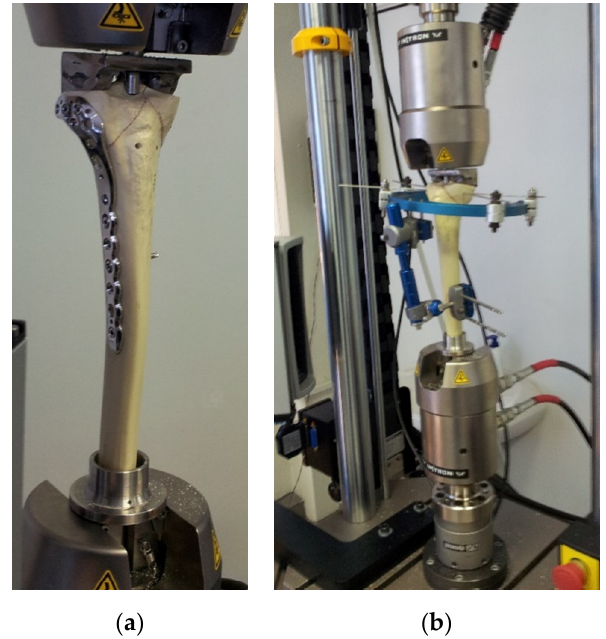
Figure 7. Test assembly—PLS system ( a ) and hybrid external fixator ( b ).